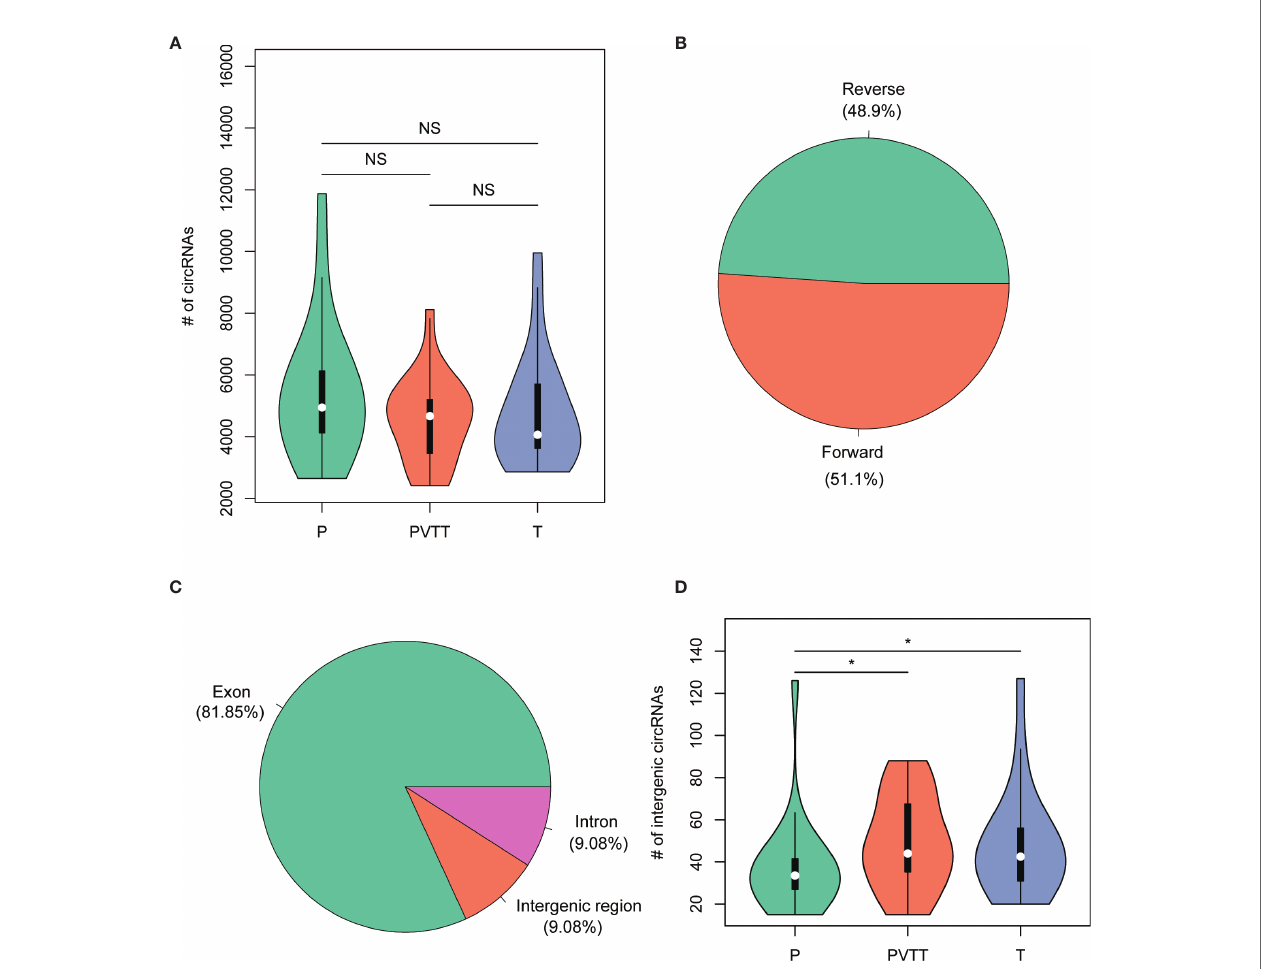
FIGURE 1 | The characteristics of the circRNAs identi fi ed by RNA-seq data. (A) The distribution of the number of circRNAs in non-tumor (P), PVTT (PVTT), and HCC (T). (B) The proportion of strands that the circRNAs were originated from. (C) The proportion of the genomic regions that the circRNAs were originated from. (D) The distribution of the number of intergenic circRNAs with high con fi dence in non-tumor (P), PVTT (PVTT), and HCC (T). *P-value < 0.05, ns, not signi fi